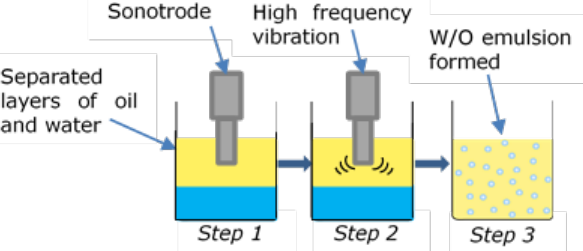
Figure 2. A sonotrode applying high-frequency vibration to a separated layer of oil and water to form a water in oil (W/O) emulsion.